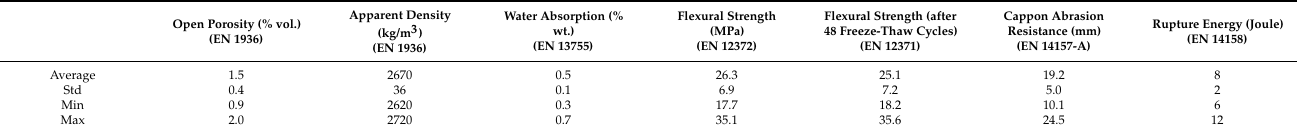
Table 7. Average values of physical mechanical properties determined for schists.